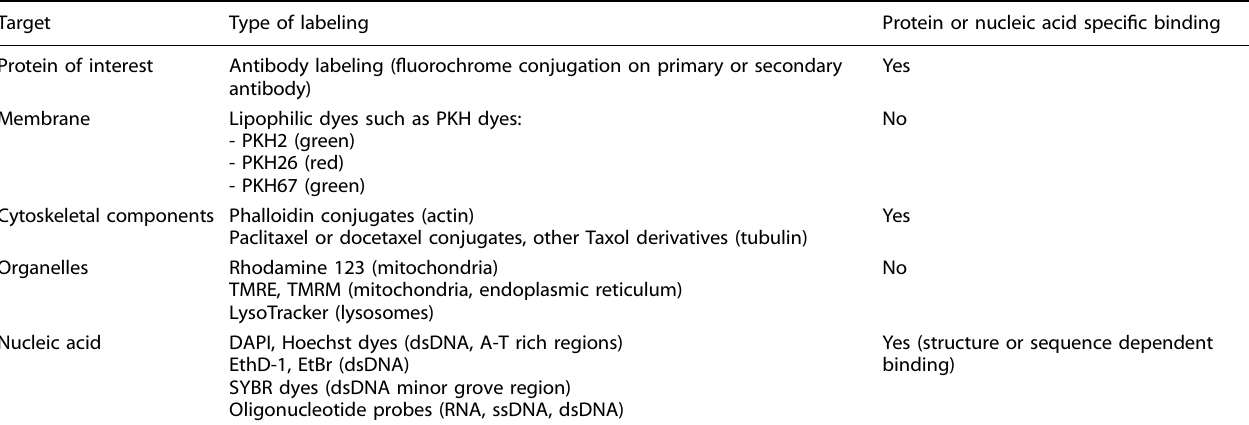
Table 3. Overview of fl uorescent staining methods to target speci fi c cellular components